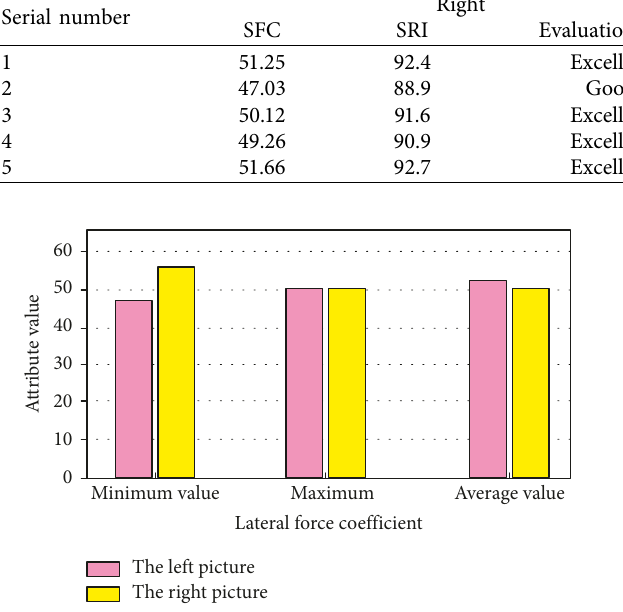
Figure 3: Antiskid performance index of the designed road surface.